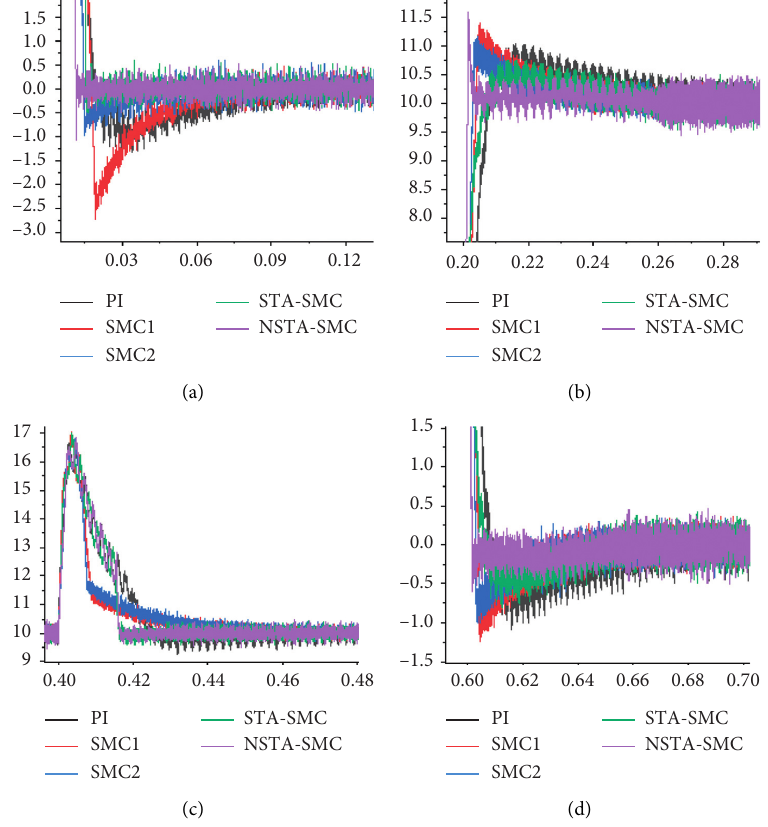
Figure 9: Enlargement of local torque